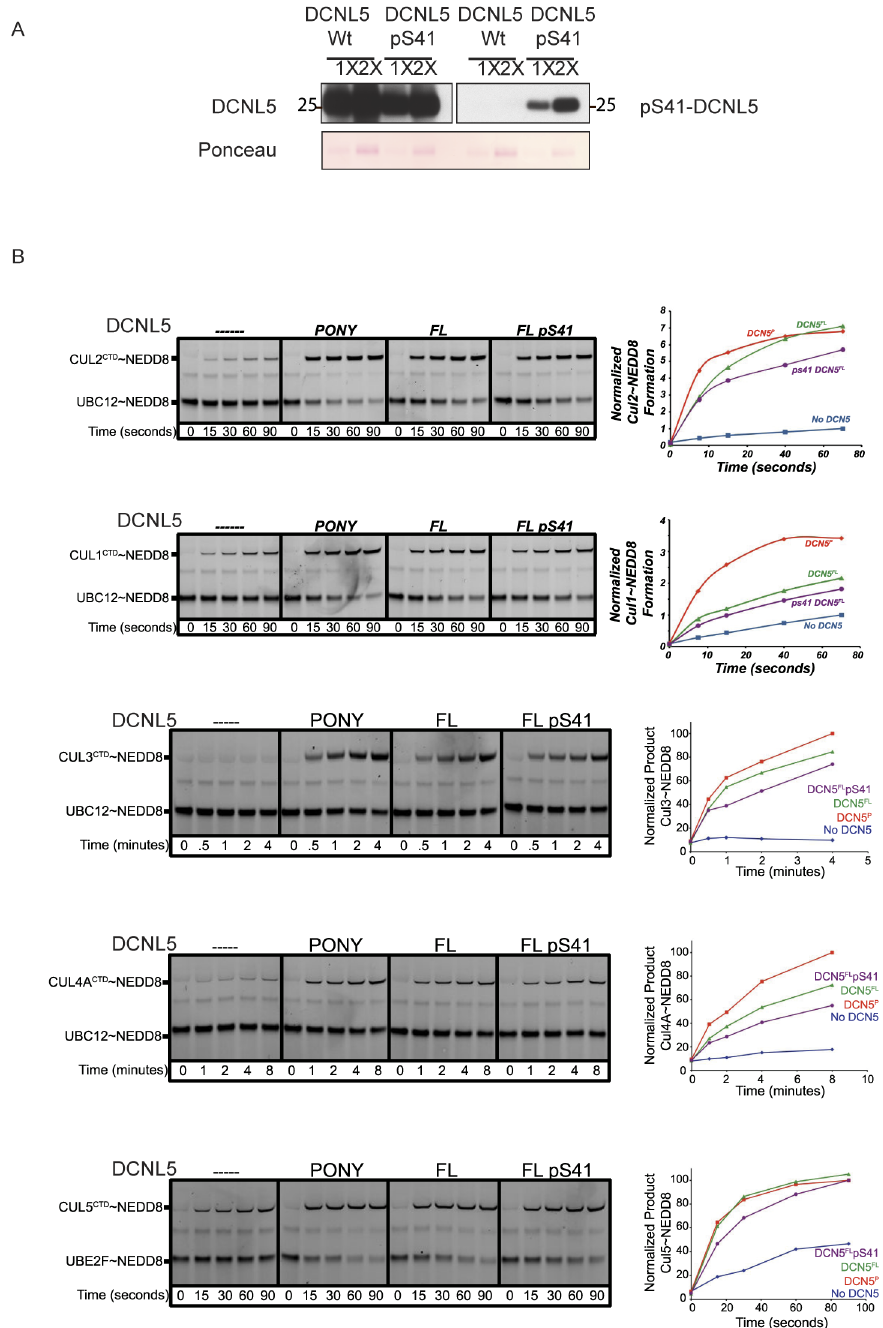
Fig 3. The phospho Serine 41 form of DCNL5 does not affect the kinetics of Cullin neddylation reactions. (A) EcAR7.SEP bacterial strain was transformed with plasmids harboring GST-DCNL5-WT or GST-DCNL5-S41TAG (the S41 codon was replaced by an amber stop codon). Purified proteins were cleaved from the GST tag using precision protease (GE) an analyzed by immunoblot with antibodies against DCNL5 or only the phospho form. (B) Pulse-chase [32P] NEDD8 transfer from UBC12NAc or UBE2FNAc (for Cullin 5 only) to the indicated Cullin C-terminal domain- RBX complexes in the absence or presence of the indicated DCNL5 constructs (PONY domain/ Full length and phosphorylated form. For comparison, all reactions were carried out under the same